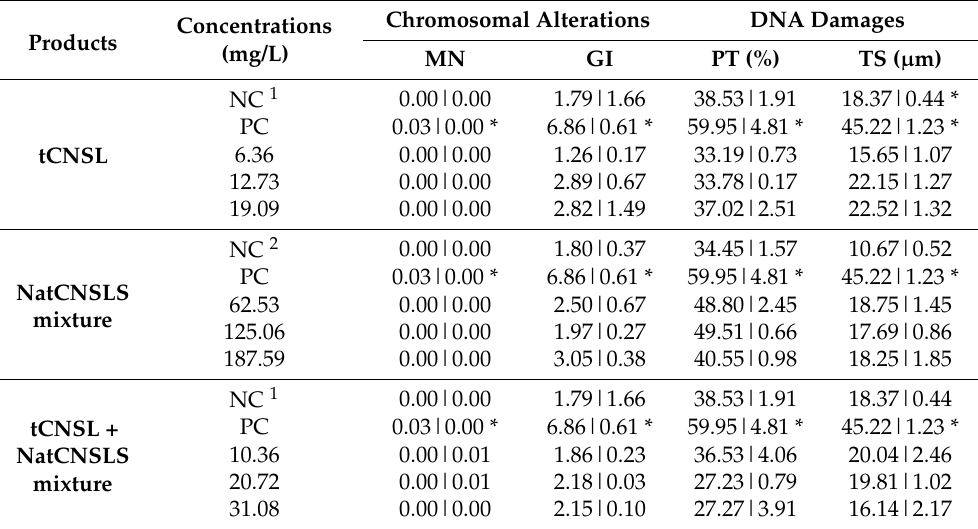
Table 4. Median and interquartile deviation of the micronucleus index (MN), genotoxicity index (GI), DNA present in the tail (PT) and tail size (TS) data obtained in tests with Oreochromis niloticus exposed to tCNSL + NatCNSLS mixture and its components (tCNSL and NatCNSLS mixture).